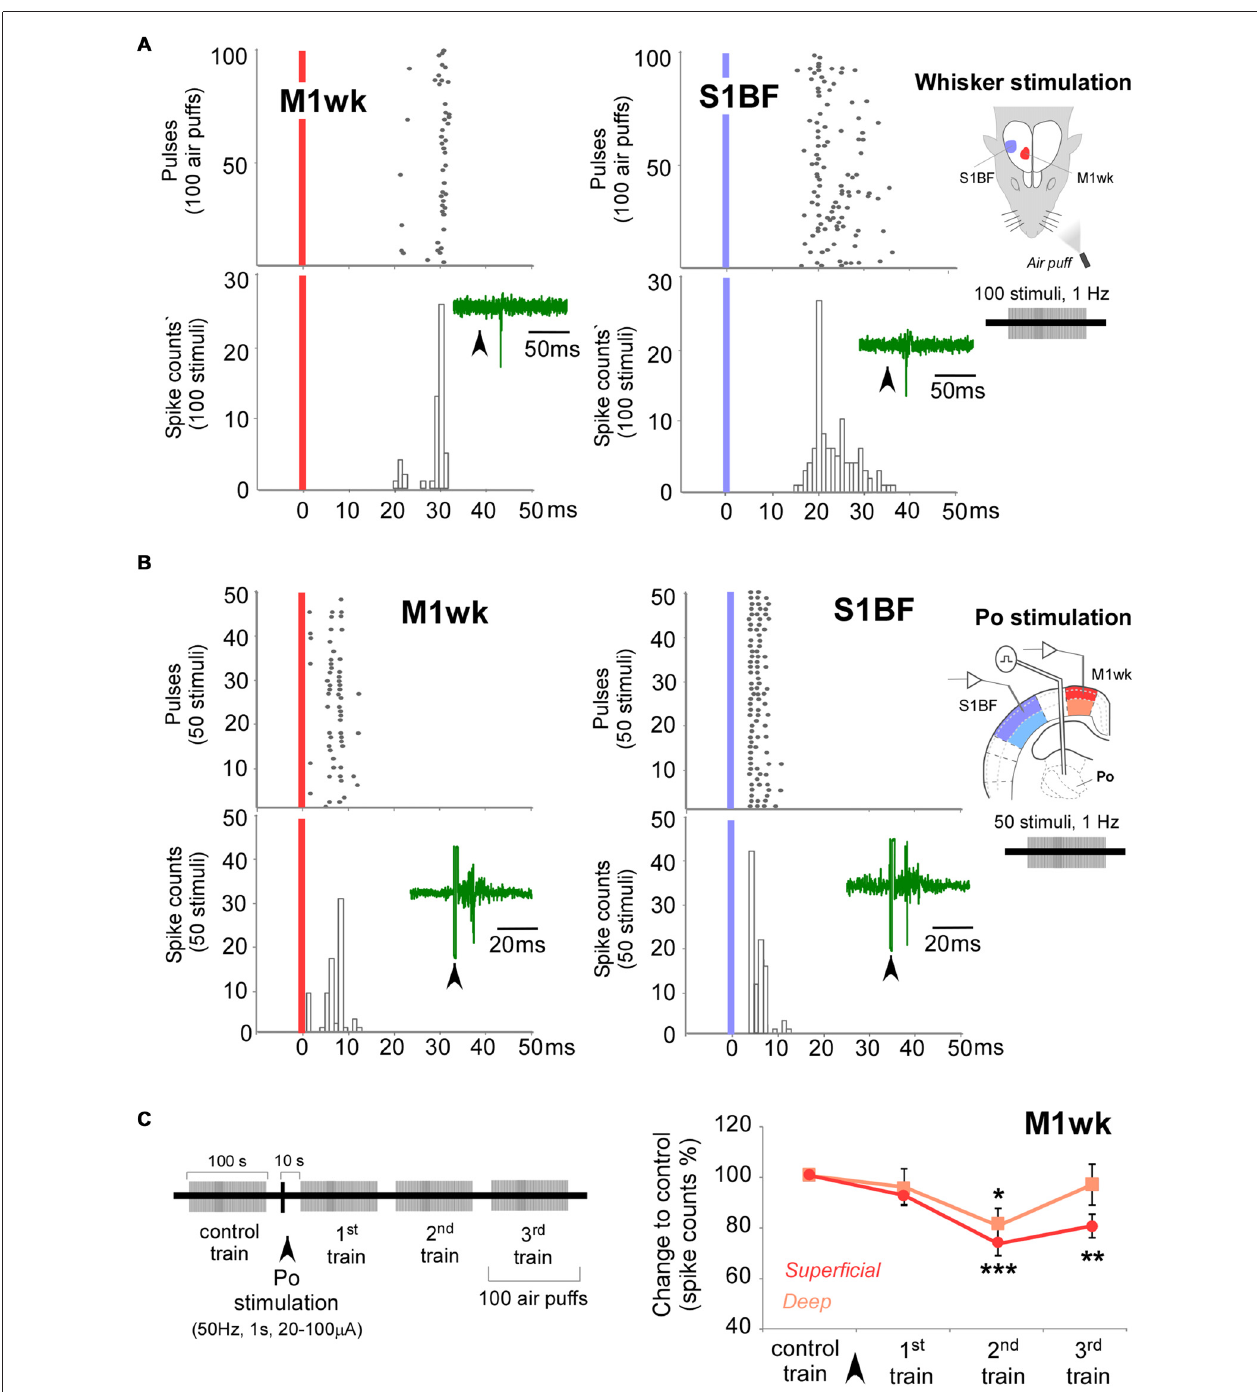
FIGURE 4 | Control exerted by Po nucleus on unit responses in M1wk cortex to passive multi-whisker stimulation. (A) Unit responses to whisker stimulation in a representative M1wk and S1BF (for comparison) superficial neuron. Peristimulus time histogram (PSTH) and raster plots shows responses as spike counts during 100 air puffs to the whiskers (1 Hz). Vertical colored bars indicate stimuli application. Representative traces of spikes are shown inside PSTHs. Diagram of the experimental protocol is shown on the right. (B) Responses to Po electrical stimulation in a representative M1wk and S1BF (for comparison) superficial neuron. PSTH and raster plots shows responses as spike counts during 50 single-pulse electrical stimulations of Po (1 Hz, 20–100 µ A). Conventions as in panel (A) . (C) Po stimulation modulates whisker unit responses in M1wk. Stimulation protocol is shown in on the left. A single train of electrical pulses (50 Hz, 1 s, 20–100 µ A) was applied to Po immediately after the “control train” of whisker pad stimuli. Unit responses were recorded in superficial and deep layers (shaded in darker and lighter color, respectively). Changes in spikes counts are measured as the percentage of differences to control values.